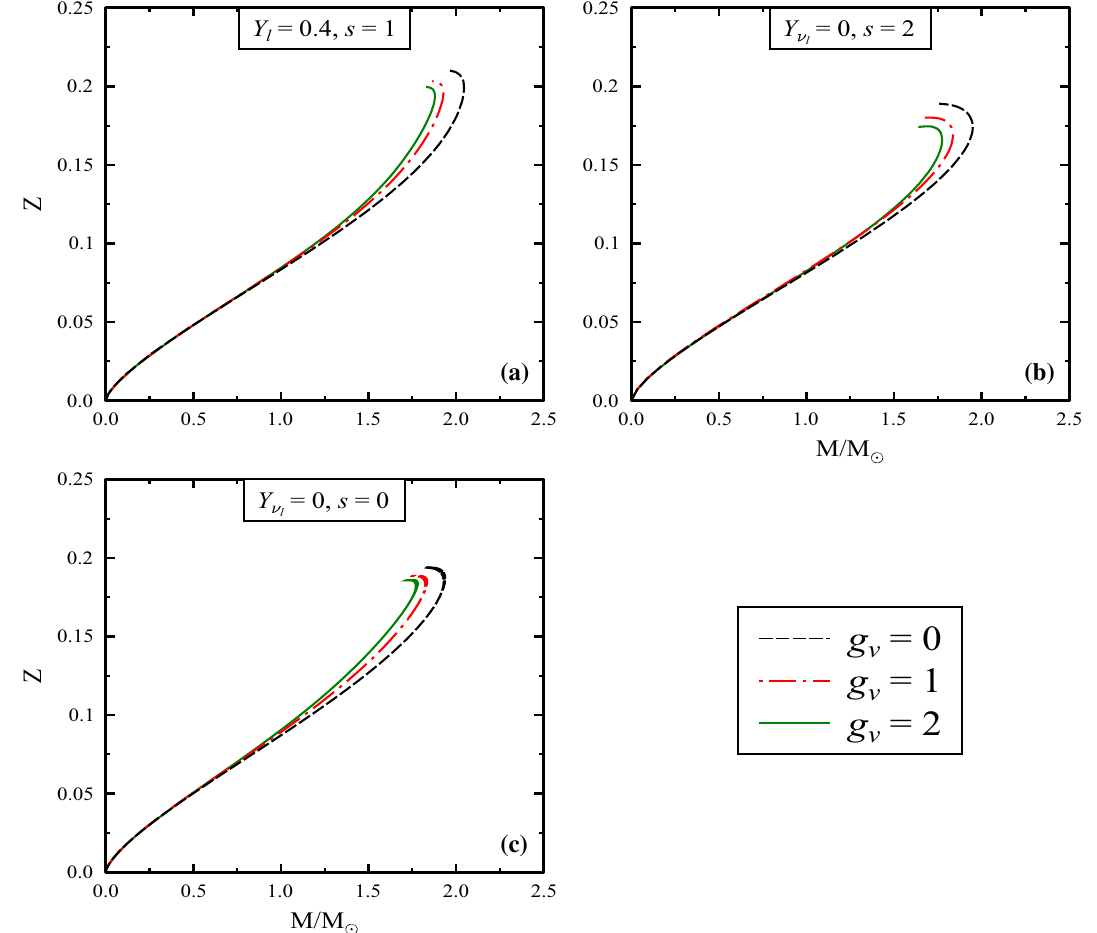
Fig. 11 The gravitational redshift versus gravitational mass of strange quark stars for different moments of the star evolution, at g v = 0, 1 and